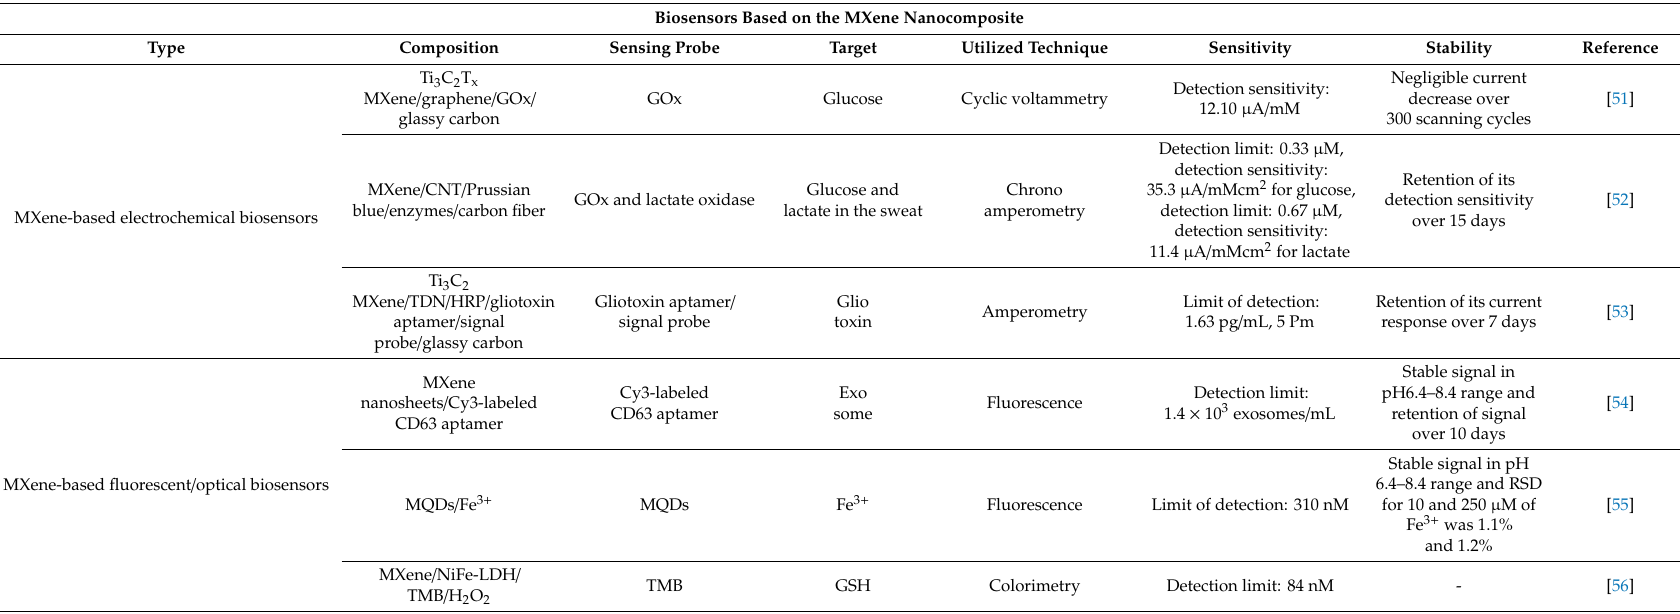
Table 2. Summary of the studies in which e ffi cient biosensors were prepared using the MXene